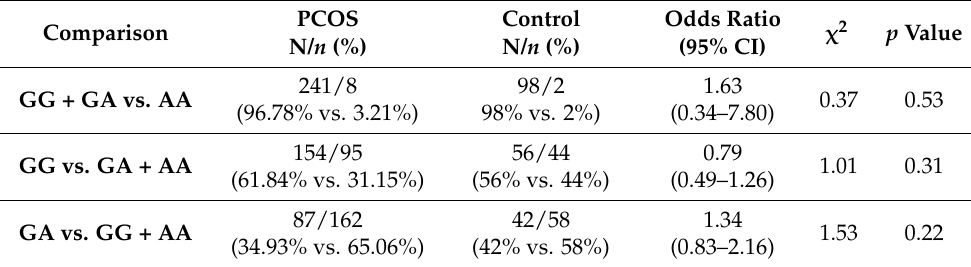
Table 2. Genetic association models (dominant, recessive and homozygote vs. heterozygote) of IRS-1 Gly972Arg polymorphism in PCOS and